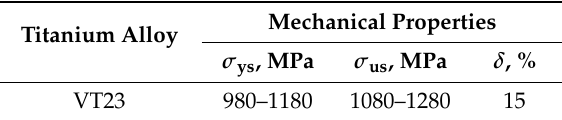
Table 1. Mechanical properties of titanium alloy